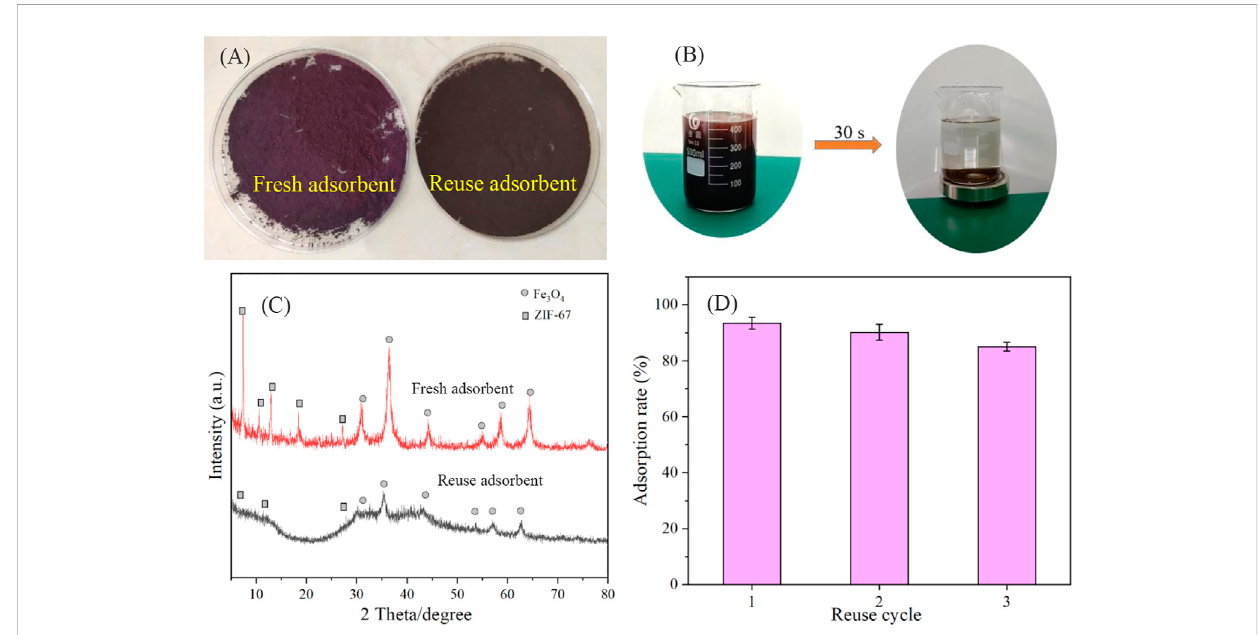
FIGURE 7 The color contrast of adsorbent before and after adsorption (A) , magnetic property of adsorbent (B) , XRD contrast of adsorbent before and after adsorption (C) , and reusability of Fe 3 O 4 @ZIF-67 (D) .